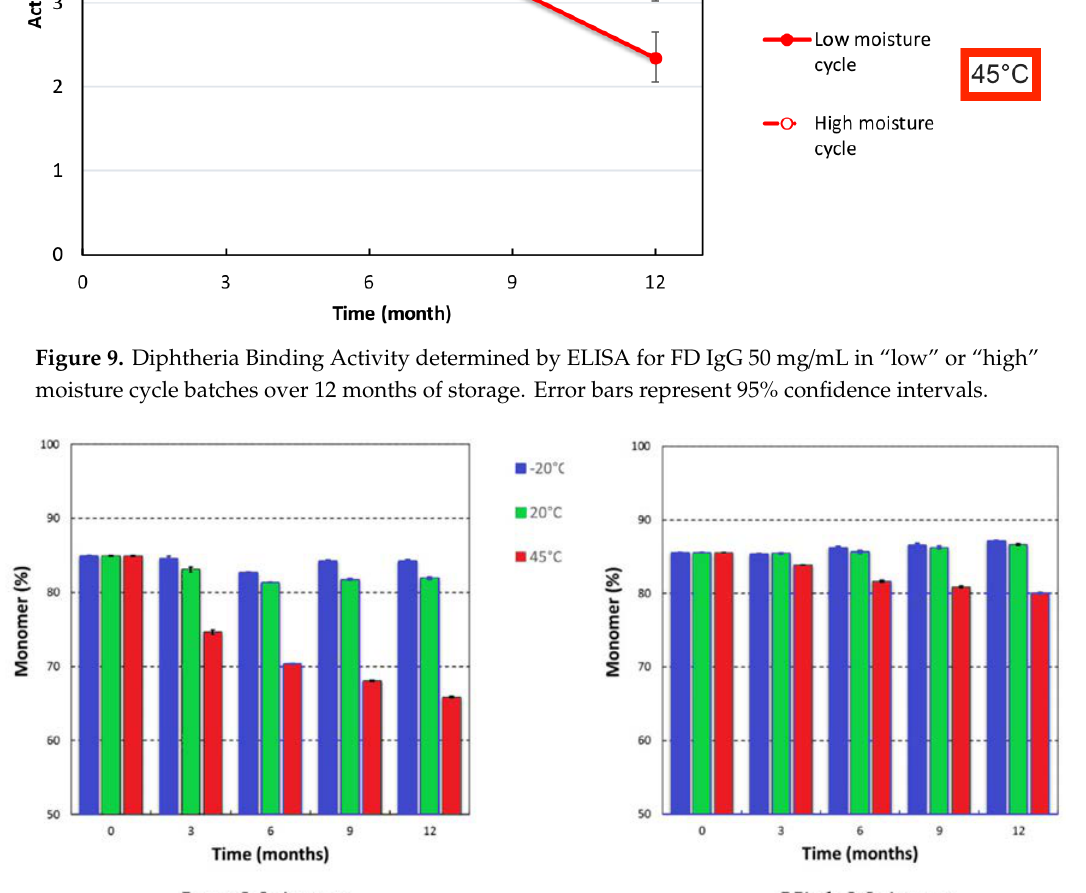
Figure 10. Change in monomer content (%) of FD IgG 50 mg / mL vials made under “low” or “high” moisture cycles over 12 months of storage. Error bars represent 95% confidence intervals ( n = 3).